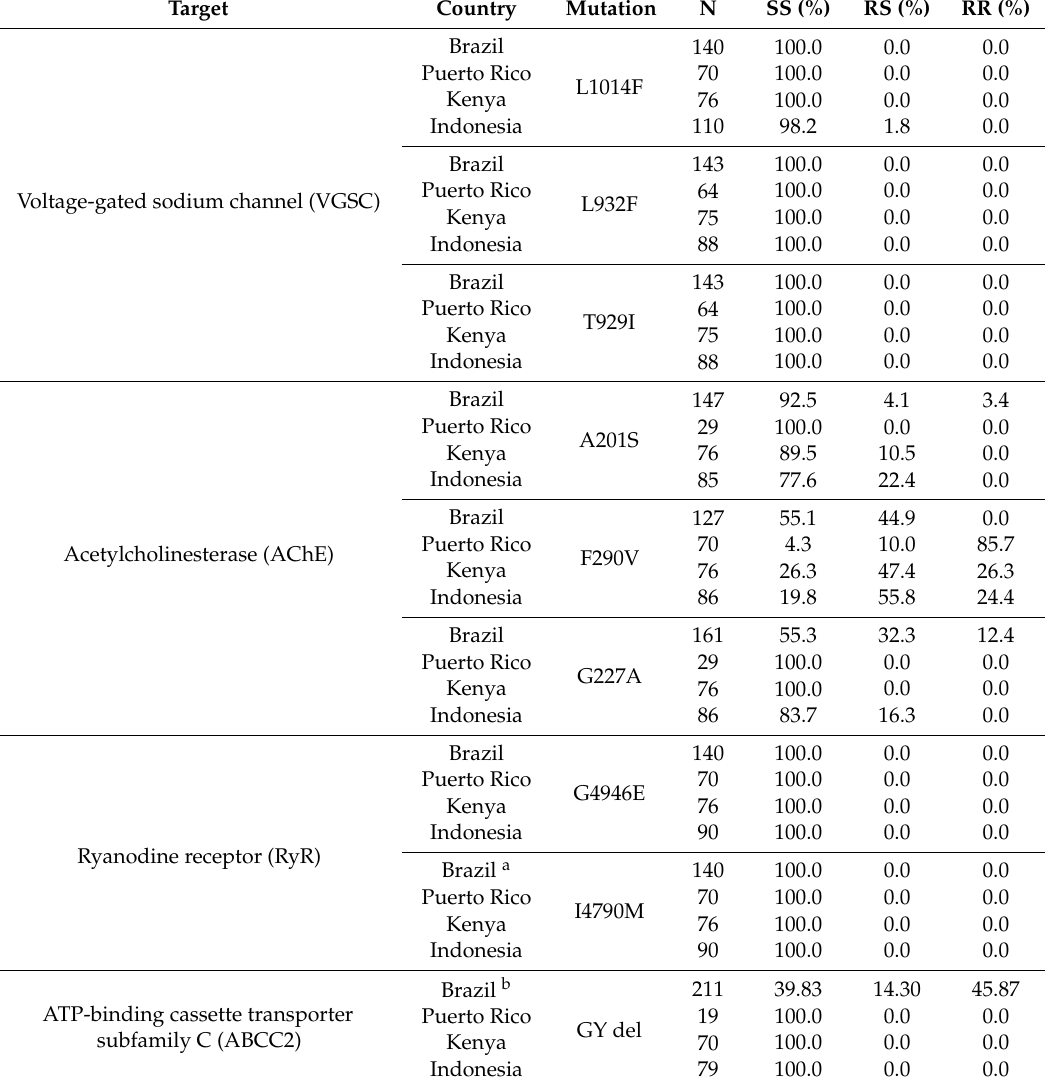
Table 1. Genotyping by pyrosequencing for di ff erent target-site mutations in major insecticide targets. In total, larvae of 34 populations from Brazil, Puerto Rico, Kenya and Indonesia were analyzed. Homozygous susceptible (SS), heterozygotes (RS) and homozygous resistant